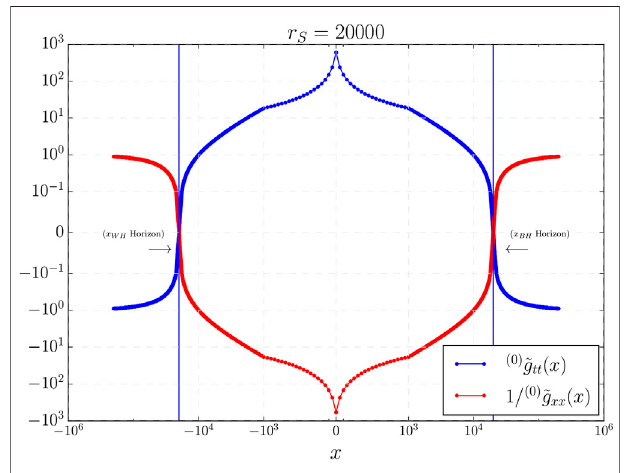
FIGURE2 | The values of the tt component ofthe metric and the inverse of xx for the metric in diagonal form. When the fi rst vanishes, horizons arise. Notice that in the region between the two horizons the discreteness is signi fi cant as represented in the separation of the dots (although in the plot we do not show all the points in the lattice but only one out of fi